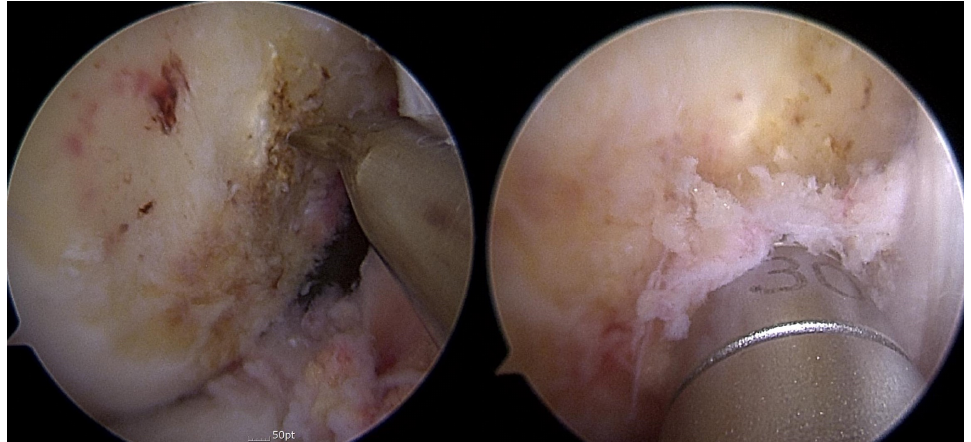
Figure 3. A femoral tunnel was formed using the transanteromedial portal method. A standard anteromedial portal was used for the viewing portal, and a far anteromedial portal was used for the working portal. The center of the anatomical footprint was marked with a microfracture awl. The femoral tunnel was formed using a cannulated reamer.